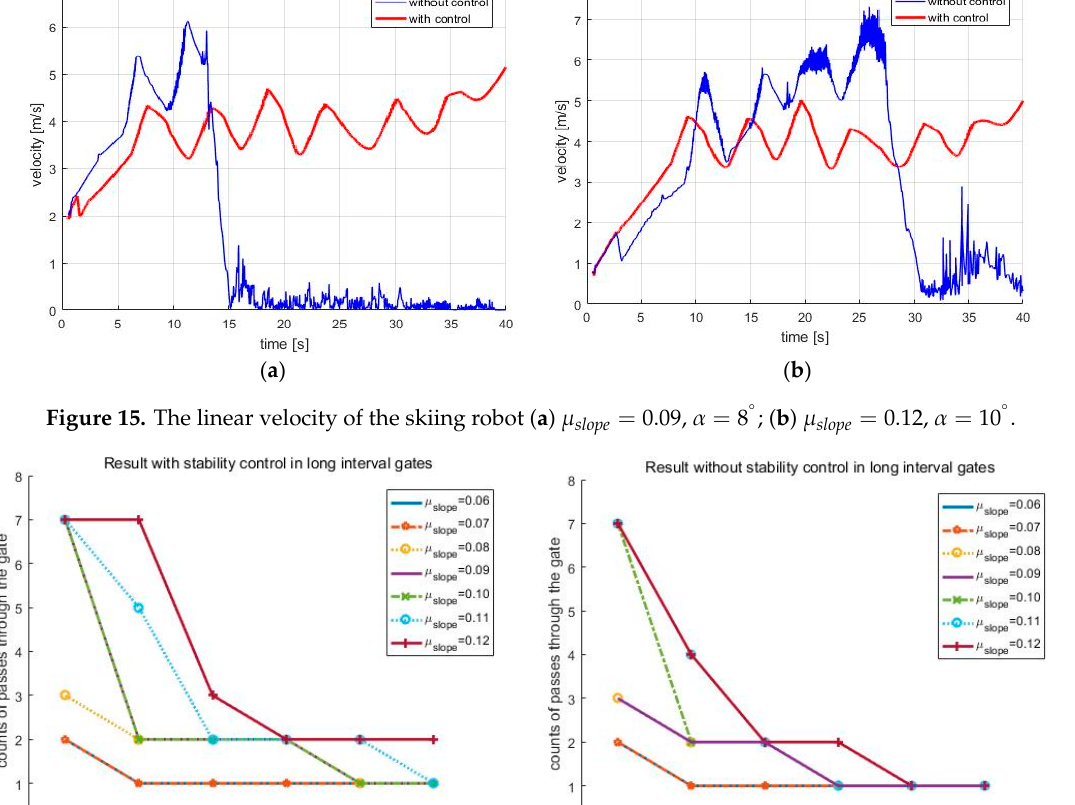
𝜇 (cid:3046)(cid:3039)(cid:3042)(cid:3043)(cid:3032) = 0.12,𝛼 = 10° .